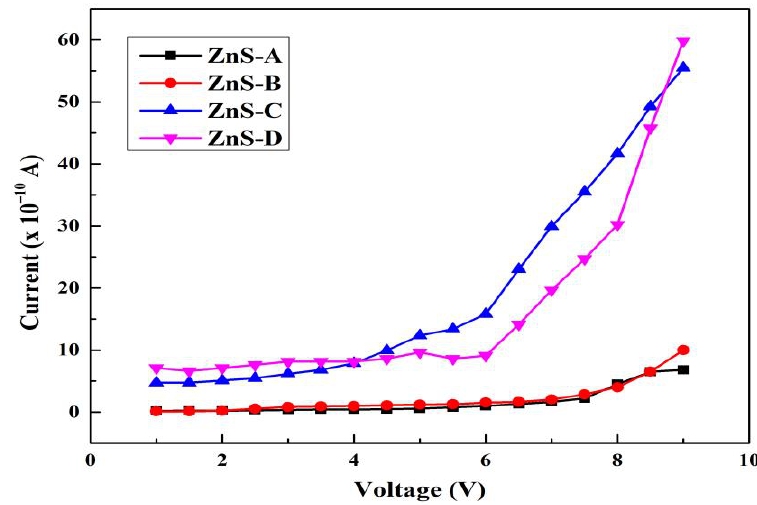
Figure 8. Voltage and current plot of ZnS-A, ZnS-B, ZnS-C, and ZnS-D thin films. Table 2. Sheet resistance values for deposited ZnS thin films at different source-to-substrate distances.